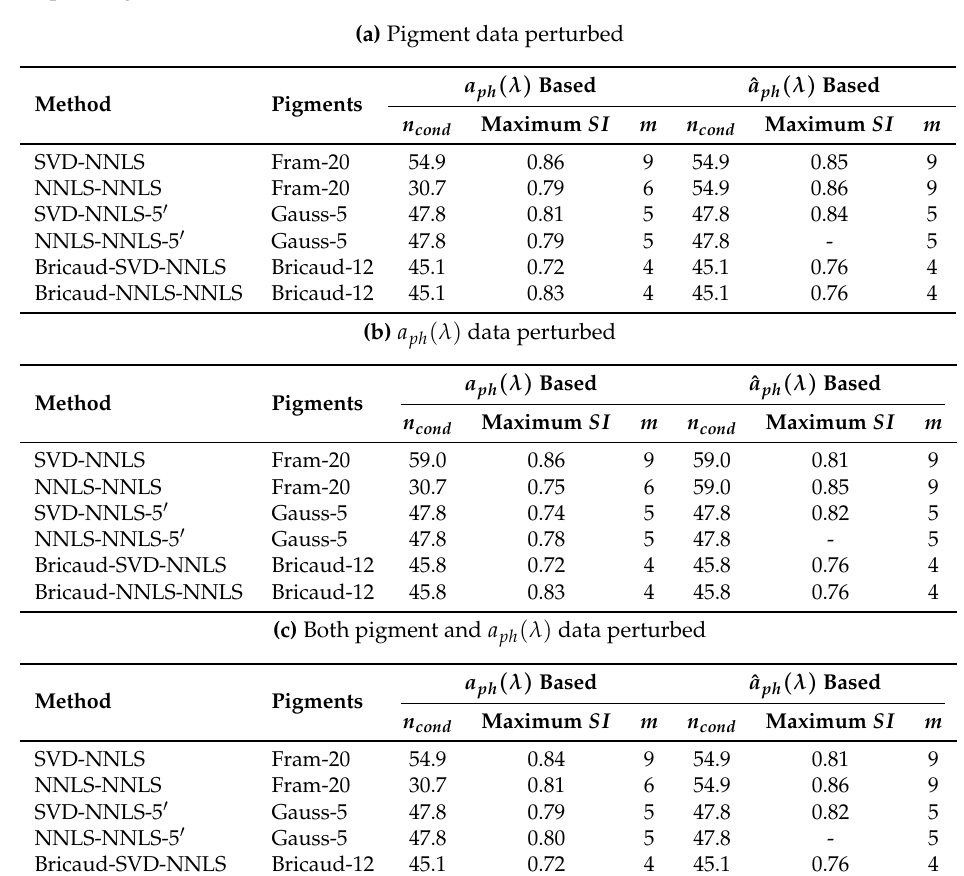
Table 3. The m types of pigments to be estimated using the matrix inversion technique and the corresponding n cond and maximum SI values.